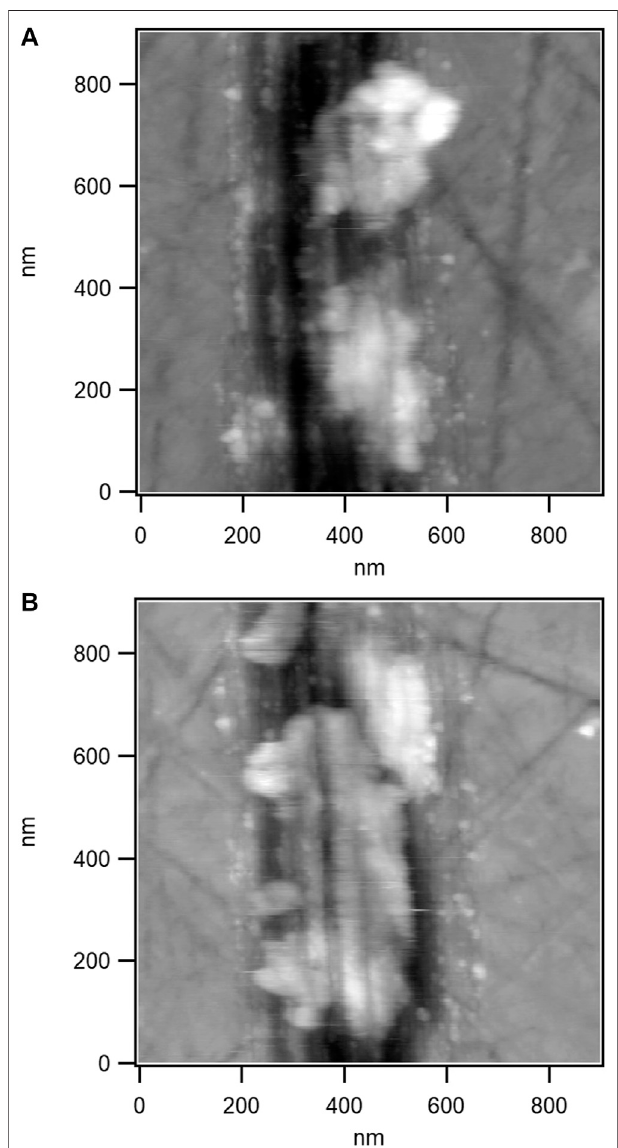
FIGURE 9 | Wear debris at different stages of embedding into a wear track. (A) ( − 12 nm < Δ Z < 16 nm) An early stage of incorporation with almost undamaged and prominent particles with few scratches is shown. (B) ( − 14 nm < Δ Z < 12 nm) A wear particle, which has been worked in and therefore is larger and fl atter (rolled out), exhibits clear wear scratches.